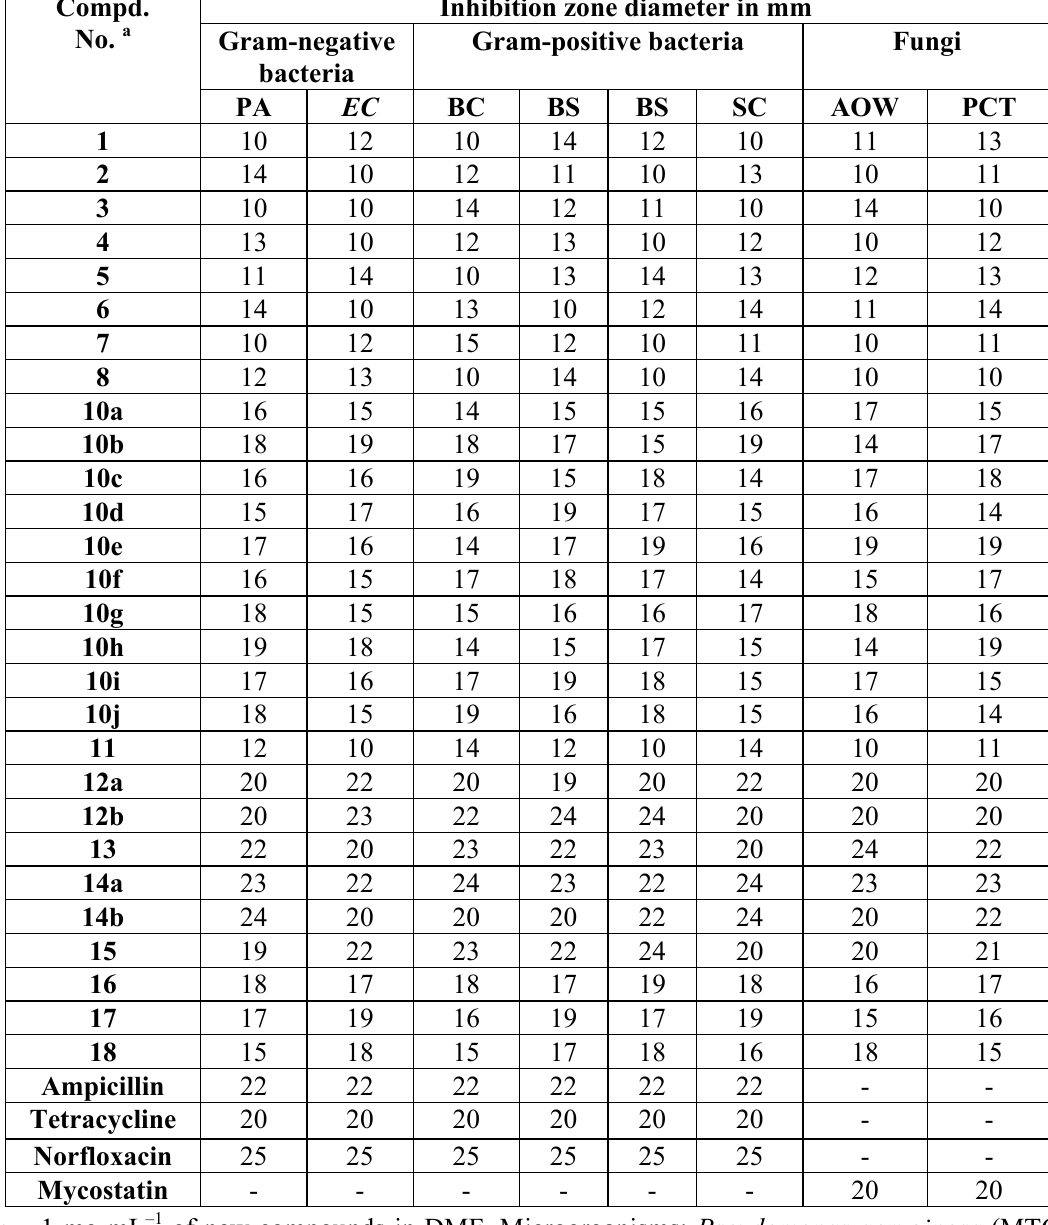
Table 1. Antimicrobial activity of the new compounds